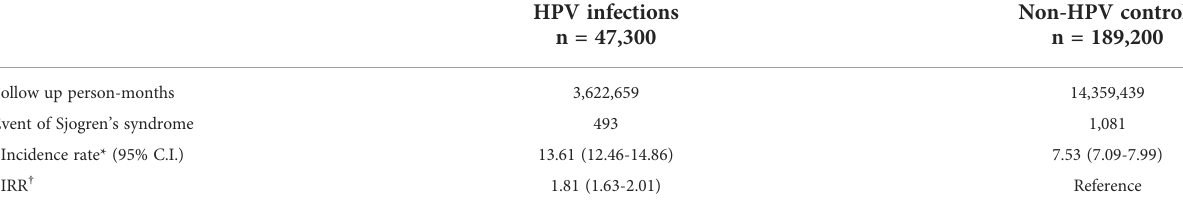
TABLE 2 Incidence of primary Sjogren ’ s